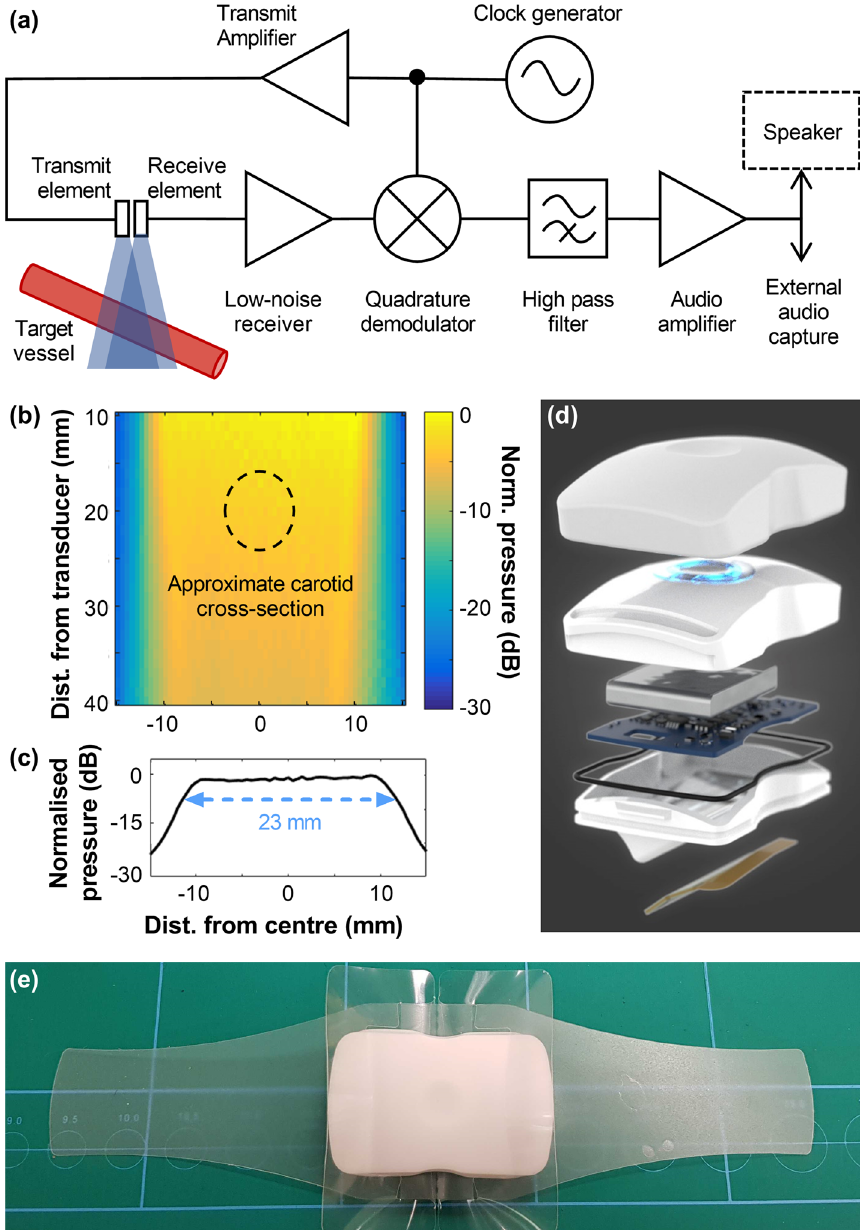
Figure 3. The CW Doppler patch. ( a ) System diagram showing the transmit and receive electronics paths. ( b ) Pressure map of the wide transmitted ultrasound beam measured in the lateral plane with a hydrophone, normalized to the peak pressure and log-scaled; with an outline of the approximate cross section of a 7-mm-diameter carotid artery superimposed on the beam (black dashed line). ( c ) Transmit beam pressure profile, log-scaled, at distance of 1 cm from the transducer showing the uniformity of the pressure amplitude (± 0.7 dB) over the active region. ( d ) Exploded view of CW Doppler patch components, including (from bottom) transducer module mounted in angled wedge, water-resistant gasket, PCB for Doppler processing and wireless communication, rechargeable battery, case with indicator LEDs, and silicone sleeve. Image by Kyle Fredricks/Flosonics Medical. ( e ) Wireless configuration of device, on a 2 ″ grid for scale, with translucent adhesive strips on each side and clear tabs, visible around the patch, to remove liner of